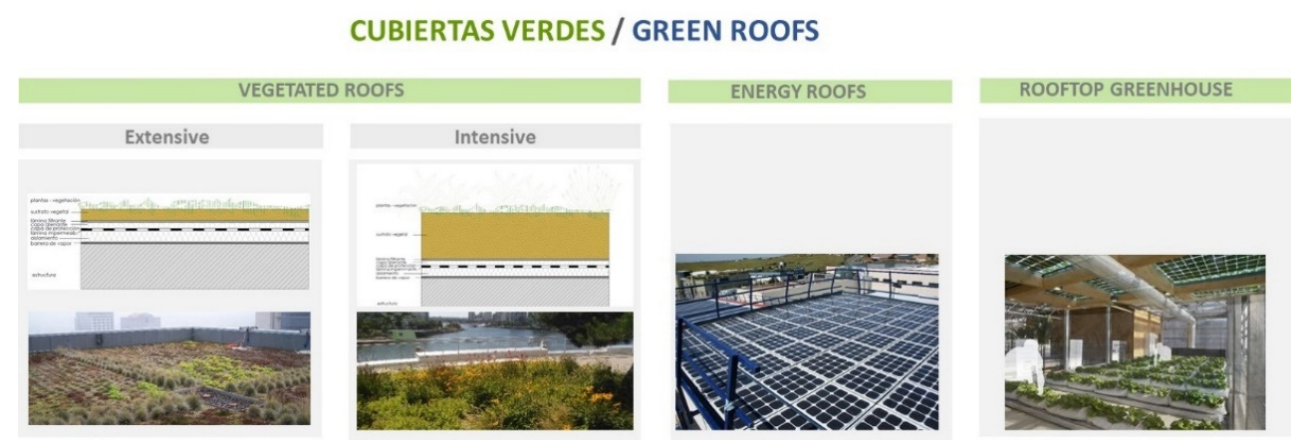
Figure A1. Types of green roofs (table and images by the authors).